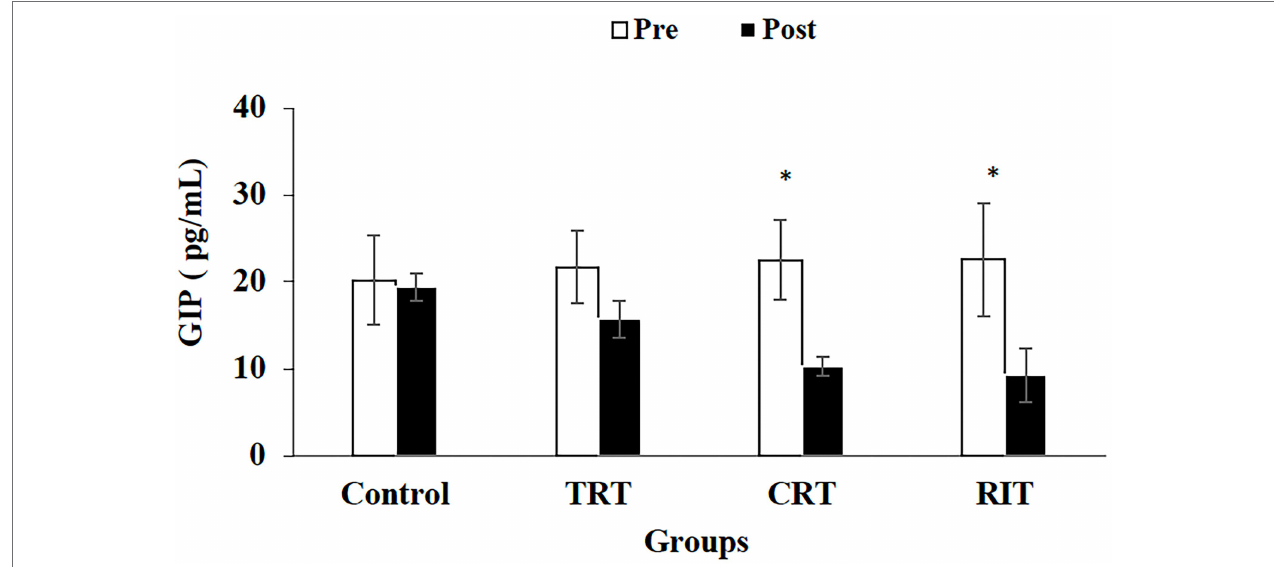
FIGURE 5 | Pre- and post-training values (mean ± SD) for Glucose-Dependent Insulinotropic Polypeptide in TRT, CRT, and IRT groups. * Indicates significant differences from the control group ( p < 0.05). # Indicated significant differences between training protocols ( p <